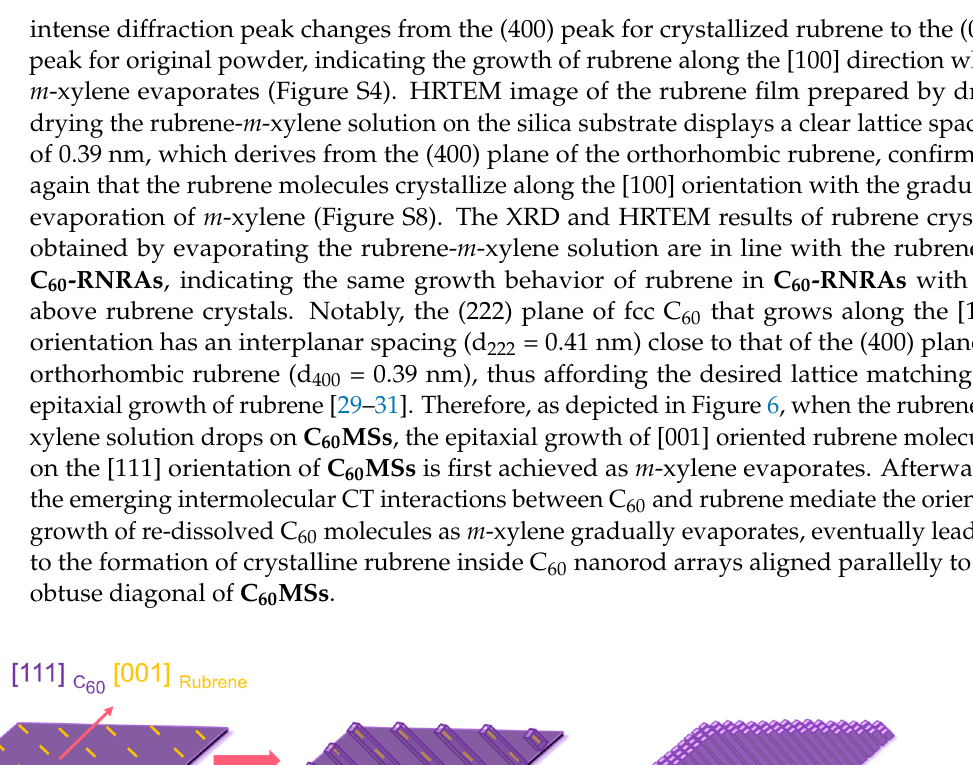
Figure 5. ( a ) UV-vis absorption spectra and ( b ) PL spectra of C 60 MSs , C 60 NRs , and C 60 -RNRAs.